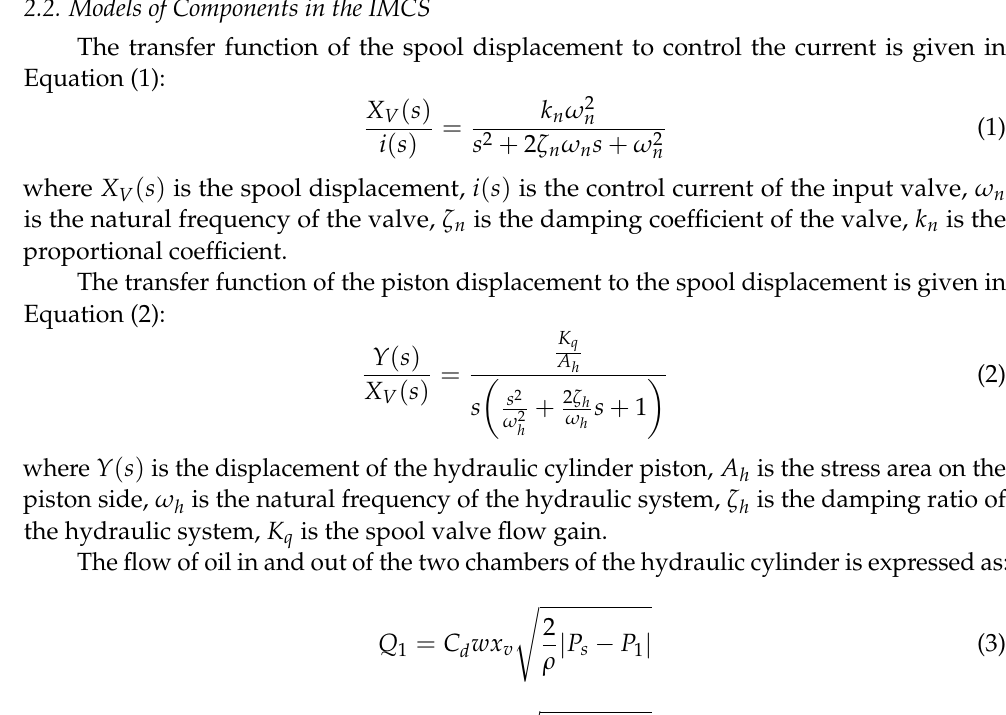
Figure 3. IMCS of the boom.